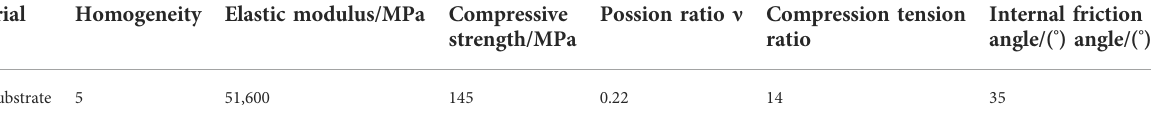
TABLE 1 Mechanical parameters of shale matrix.